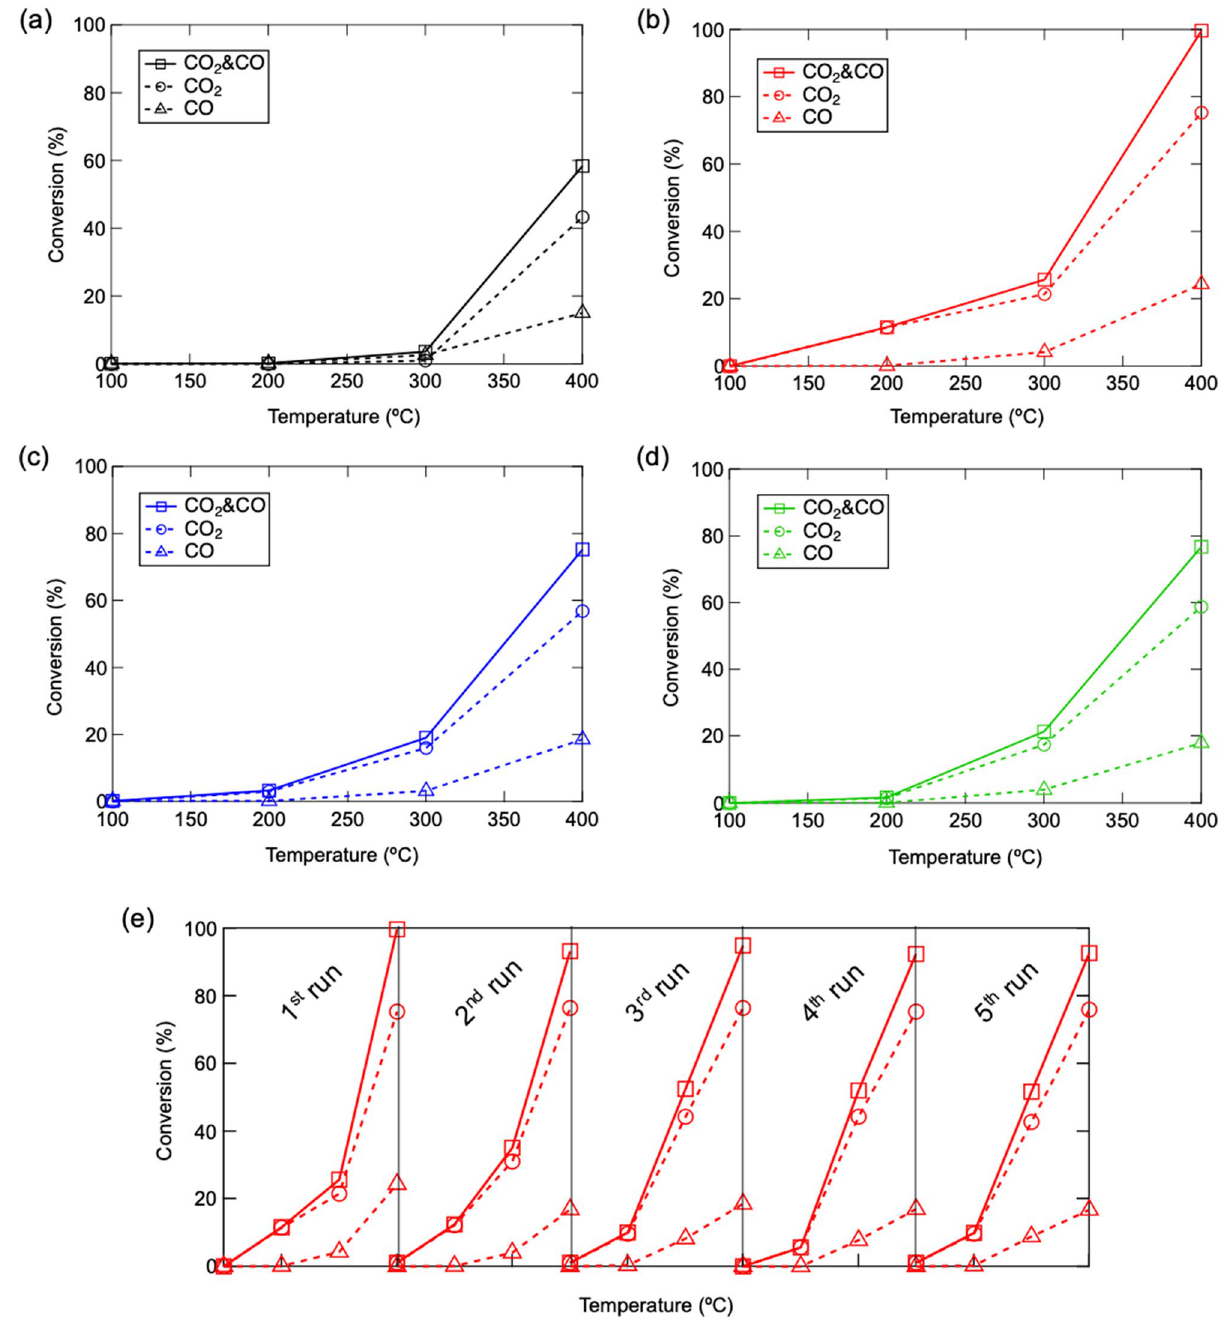
Figure 6. CO 2 /CO conversion of VOC under different temperatures on ( a ) raw and mechanochemically activated HAp via ( b ) 3 mm, ( c ) 10 mm and ( d ) 15 mm ball, and ( e ) cyclic test of VOC decomposition on HAp activated via 3 mm